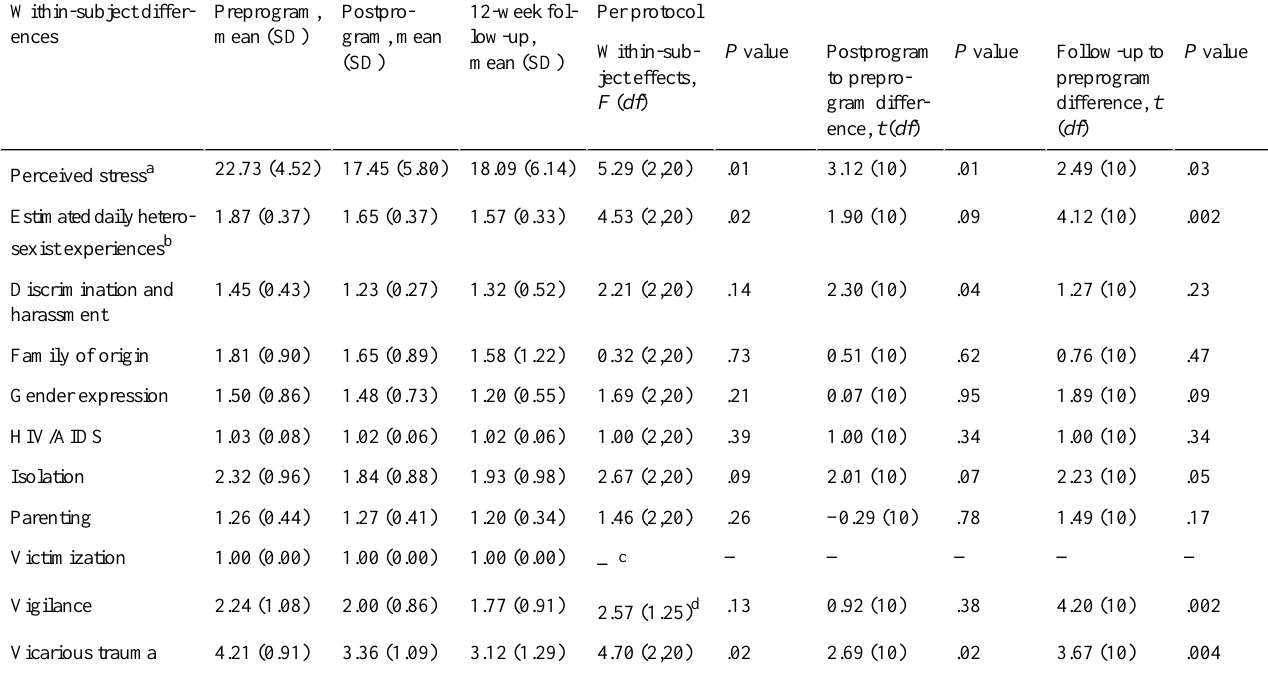
Table 3. Within-subject differences in perceived and minority stress in lesbian and bisexual women participating in online mindfulness-based stress reduction by per-protocol